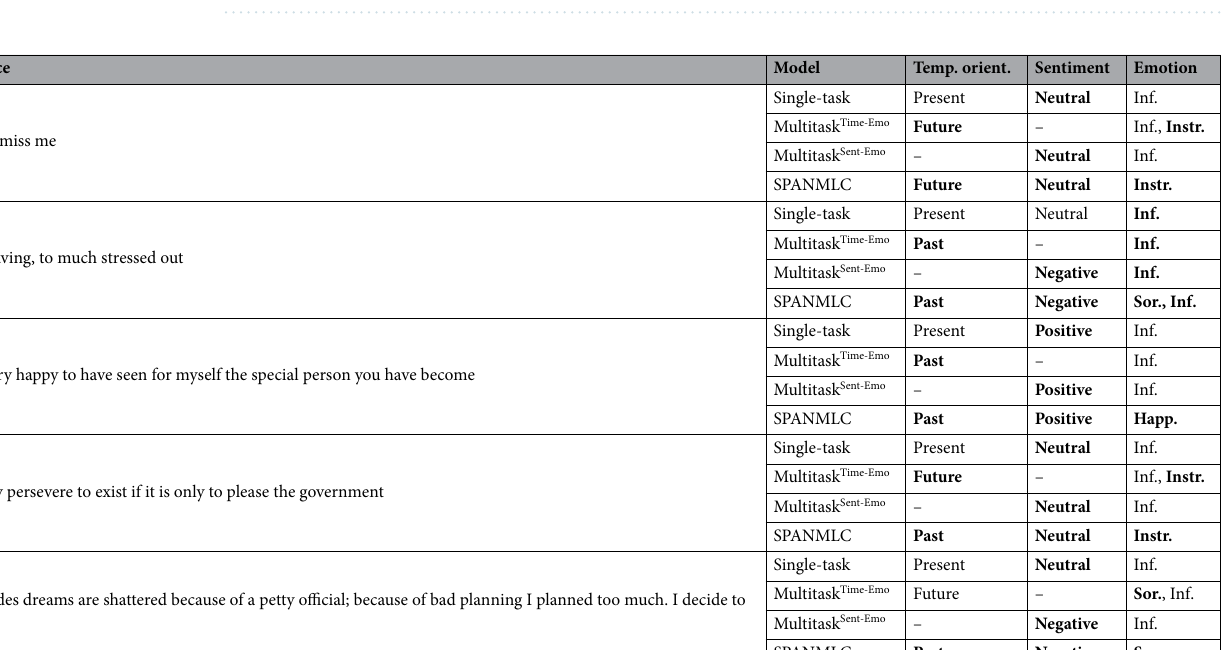
Figure 7. Attention visualization of the representations of a sentence ( Please do write something; name. ) from the different attention layers.